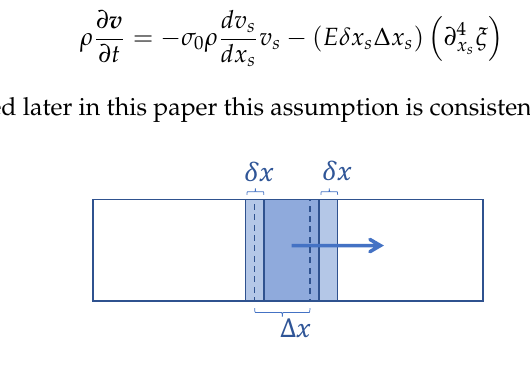
Figure 2. Conceptual illustration of potential energy associated with gradient of normal strain. ∆ x represents width of harder portion and δ x represents width of softer